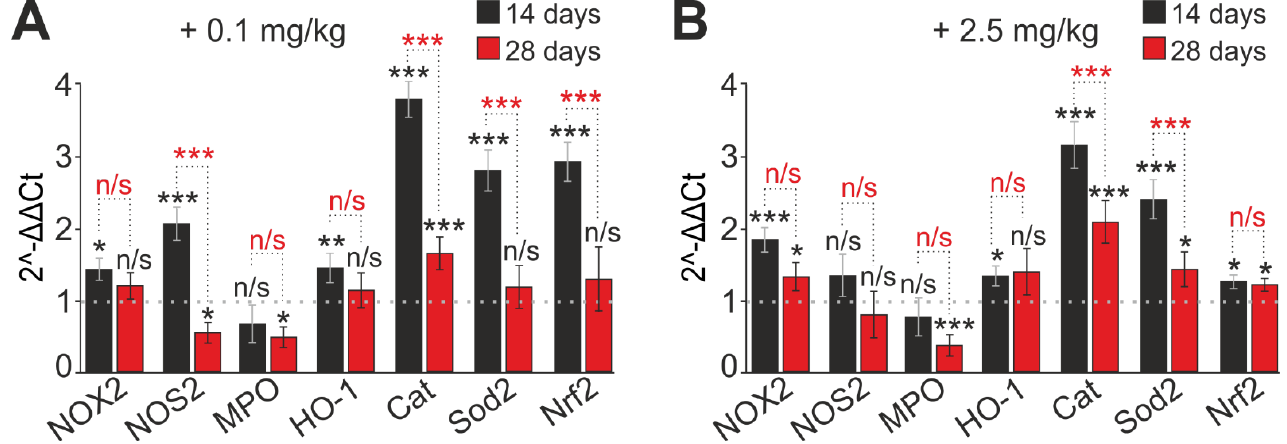
Figure 4. Changes in intracellular expression of neutrophil genes involved in redox homeostasis after administration of 0.1 ( A ) and 2.5 ( B ) mg/kg SeNPs for 14 and 28 days. Neutrophils prepared from mice 14 (black bars) and 28 (red bars) days after daily injection of 0.1 mg Se/kg ( A ) and 2.5 mg Se/kg ( B ) SeNPs. GAPDH was used as housekeeping gene. Dashed line — level of gene expression in controls (mice with administration of saline). Data are expressed as mean ± SEM of five independent experiments. Statistical analysis of experimental groups versus control was performed with paired t -test and marked with black asterisks. Significance between experimental groups marked with red asterisks: *** p < 0.001, ** p < 0.01, and * p < 0.05; n/s — no significance.